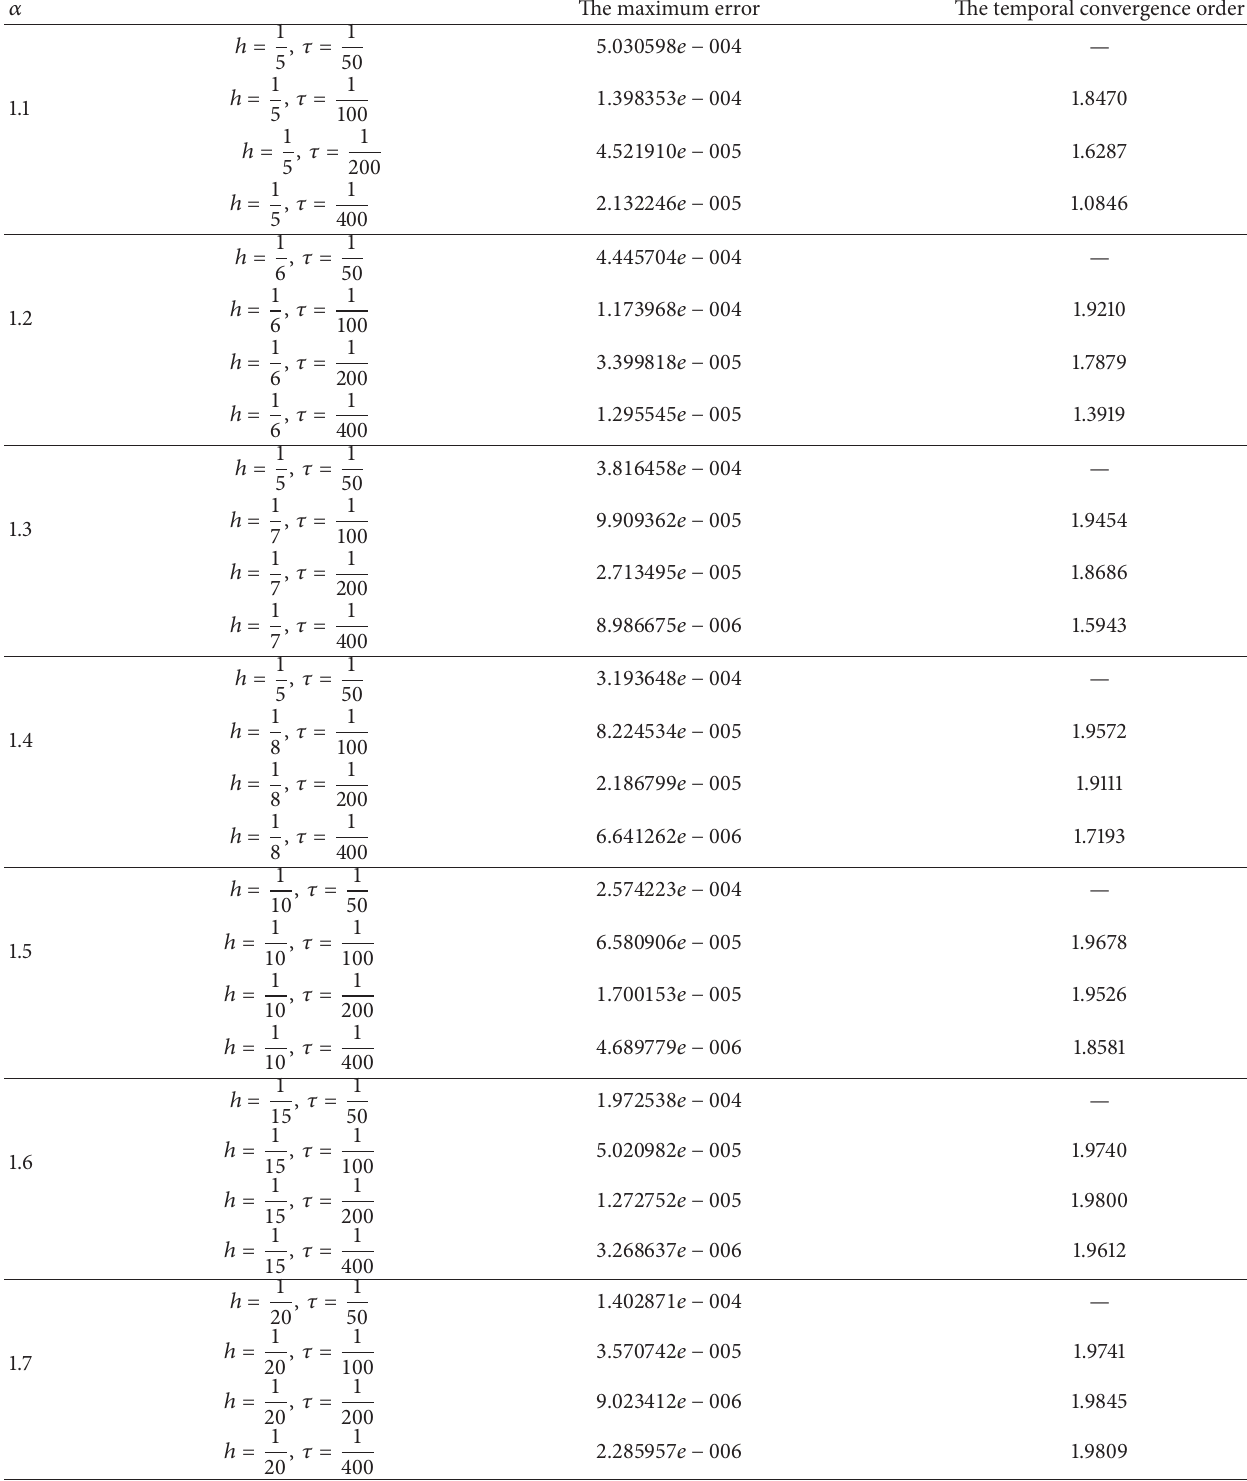
Table 2: The maximum error and temporal convergence order by Numerical Scheme II (see (61)).